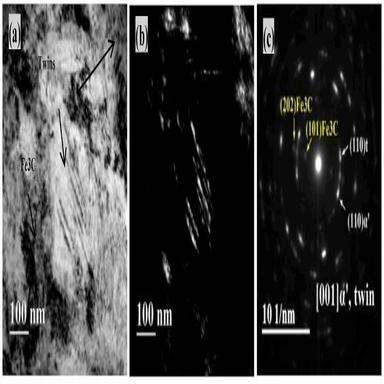
(a)TEM Bright-field image, (b) Darkfield Image (α′reflections) and (c) corresponding selected area diffraction pattern (SAED) of sample B. The region corresponds to the WEL region indicated by red square in. (For interpretation of the references to colour in this figure legend, the reader is referred to the Web version of this article.)